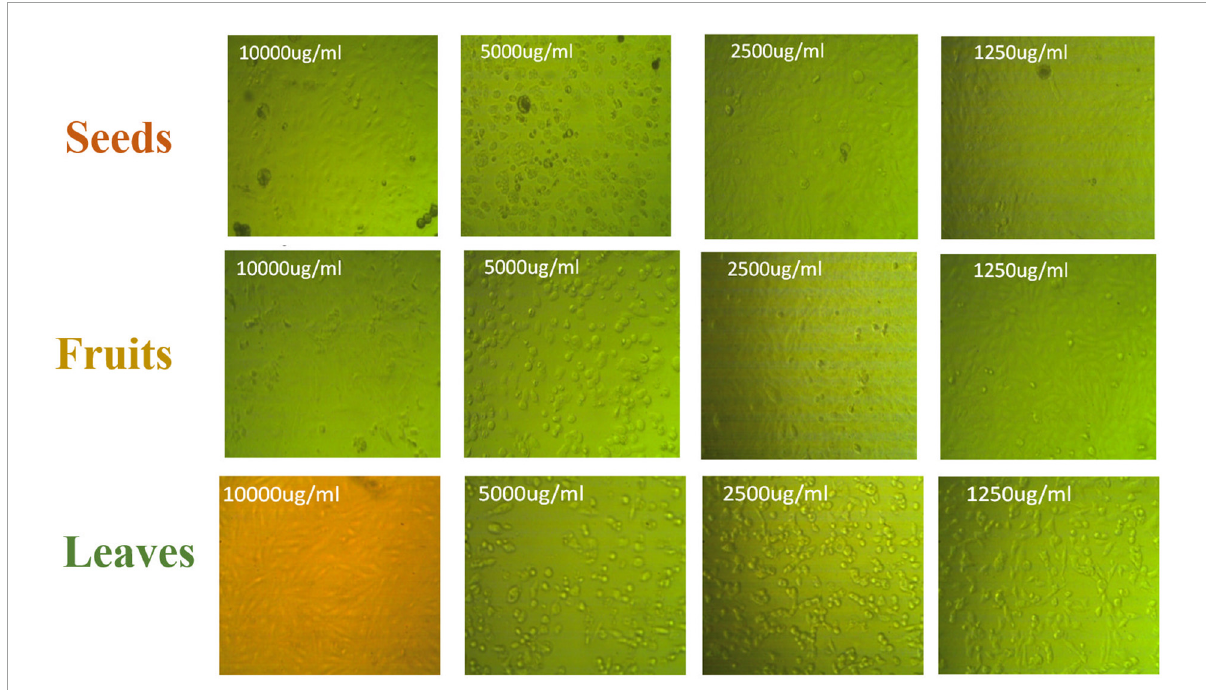
FIGURE10 Panc1 cytotoxic morphology after the treatment with leaf, seed, and fruit extracts separately in comparison with control.